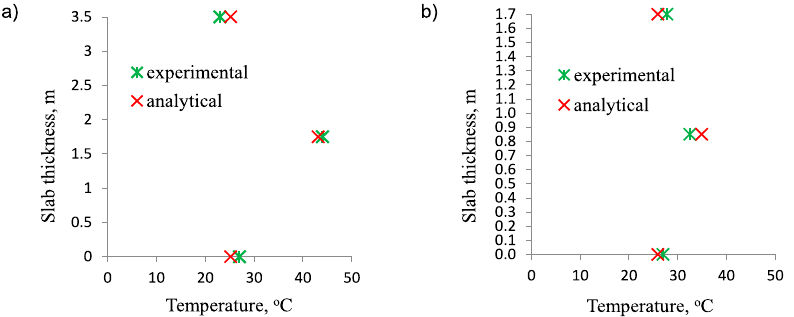
Figure 10. Comparison of experimental and analytical results for the foundation slab: ( a ) Points ‘1’, ( b ) points